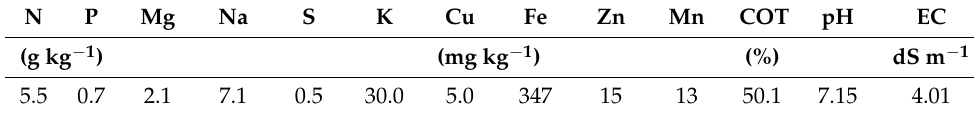
Table 2. Chemical composition of sun-dried green coconut husk